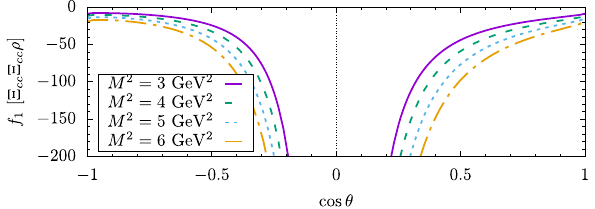
Fig. 4 The dependence of the coupling constant f 1 for Ξ cc Ξ cc ρ on cos θ for the shown values of M 2 and at